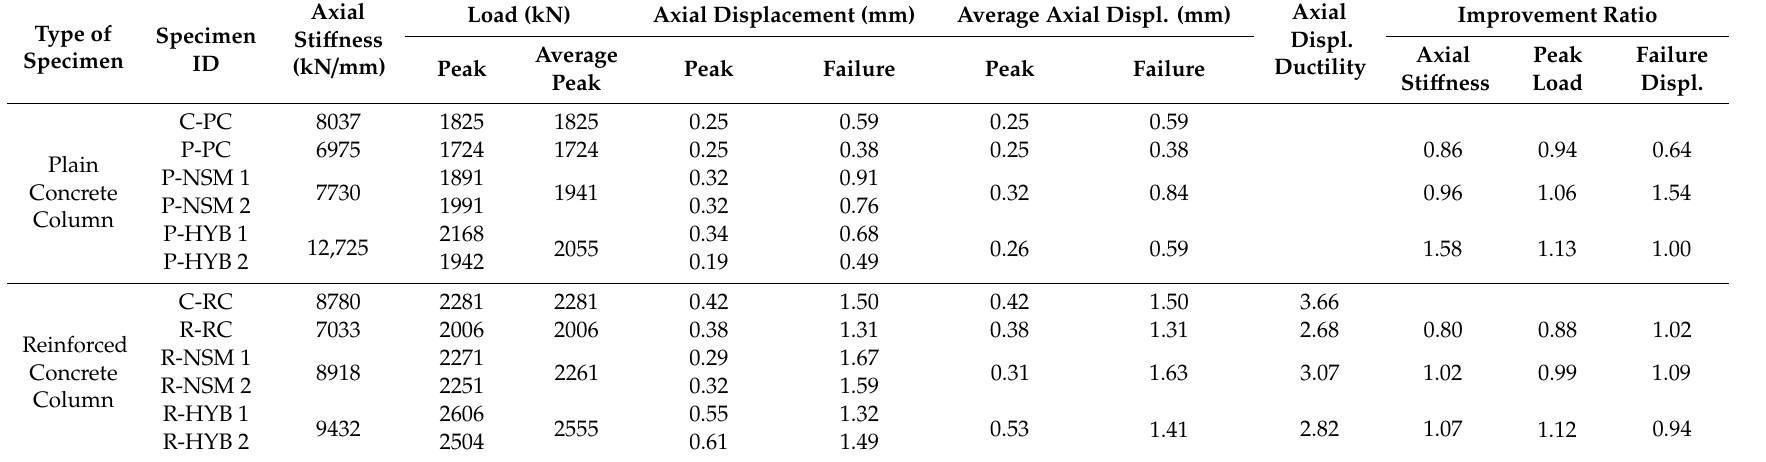
Table 3. Test results of pre-damaged PC and RC columns under axial